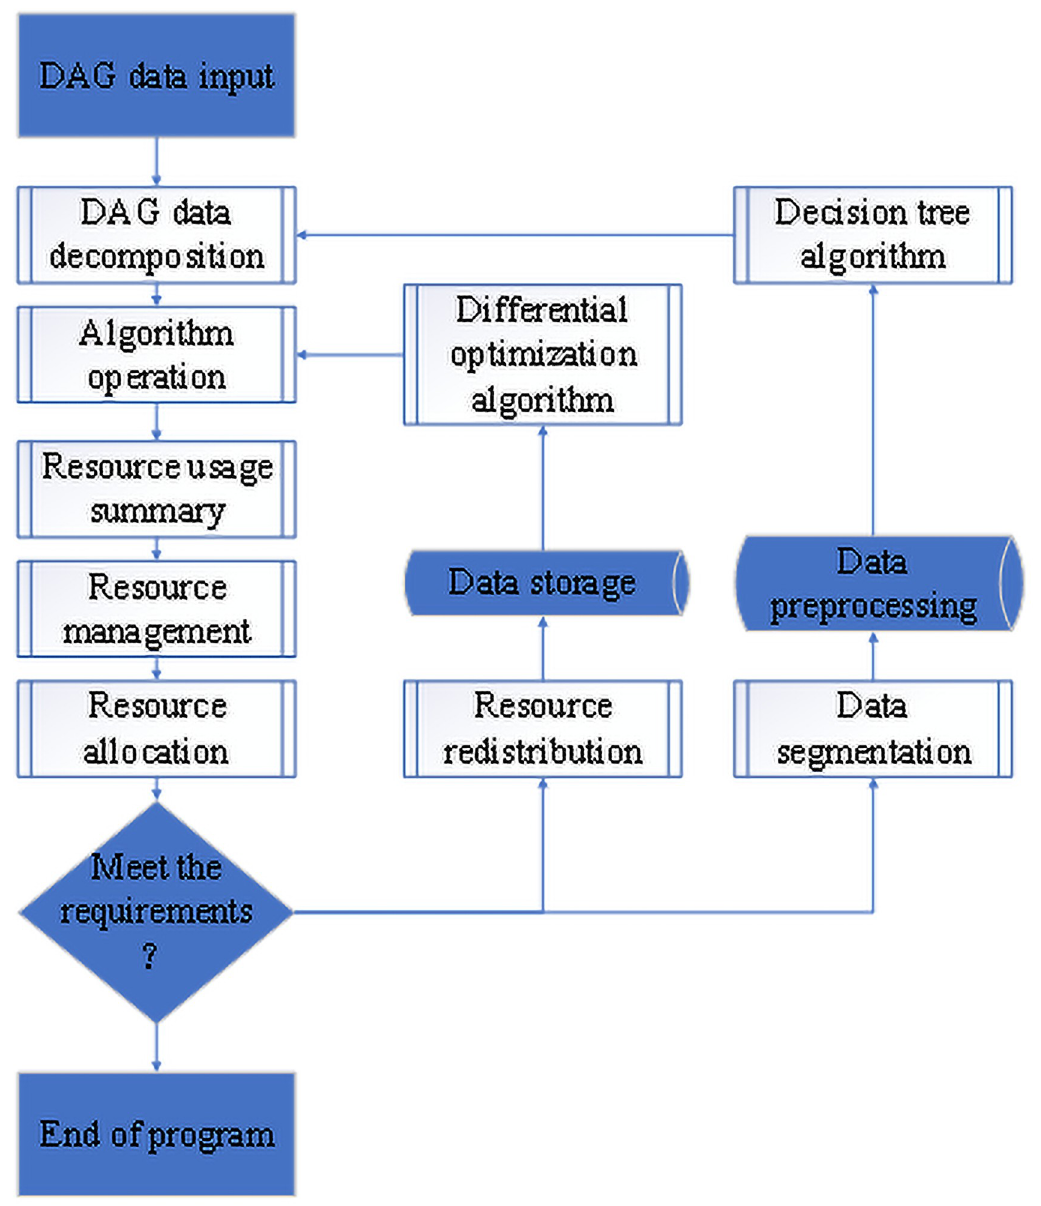
Fig 4. Overall process of the CDAG algorithm. function and Rastrigin function to test the searching performance of CABC (Crossover Artifi- cial Bee Colony) algorithm. Table 1 provides the specific parameters of the experiment. In the experiment, the number of edge clusters is set to 600, the range of hot spots is set to 1–50, and the population size is set to 126. Meanwhile, the maximum number of searches is set to 100, and the termination condition is set to 100,000 iterations.